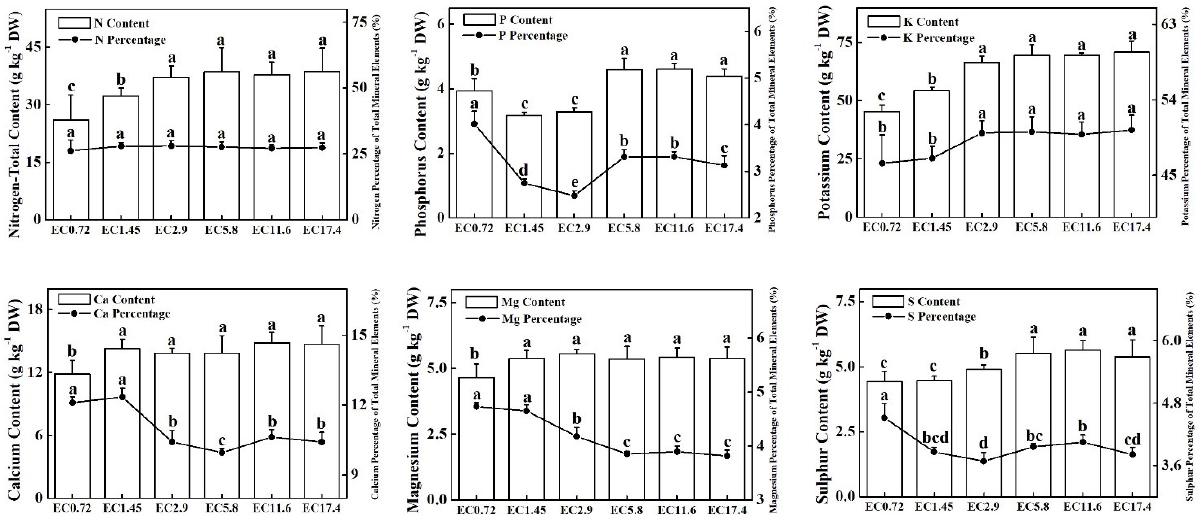
Figure 6. Effects of different EC treatments on the contents of macro plant mineral elements (PME) and their percentage of total PME after 25 days of treatment. EC0.72, EC1.45, EC2.9, EC5.8, EC11.6, and EC17.4 represent the different nutrient solution electrical conductivities of 0.72 dS m −1 , 1.45 dS m −1 , 2.9 dS m −1 , 5.8 dS m −1 , 11.6 dS m −1 , and 17.4 dS m −1 . Data represent the mean ± SD ( n = 3). Different letters indicate significant differences at α = 0.05 based on the Least Significant Difference test.